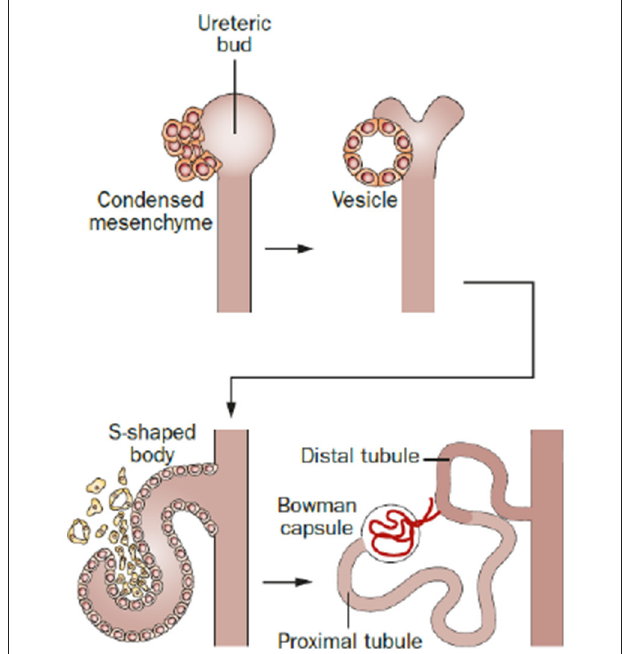
FIGURE 2 | Phases of nephron development in all animals. The metanephric mesenchyme condenses around the ureteric bud and is induced to convert into epithelium and generates in sequence a vesicle and an S-shaped body. Then, the S-shaped body becomes invaded by blood vessels at one extremity and elongates and segmentates at the other, thus generating the whole nephron. This sequence of events is similar during development across all animal species. Reprinted by permission from Macmillan Publishers Ltd: ( Romagnani et al., 2013).